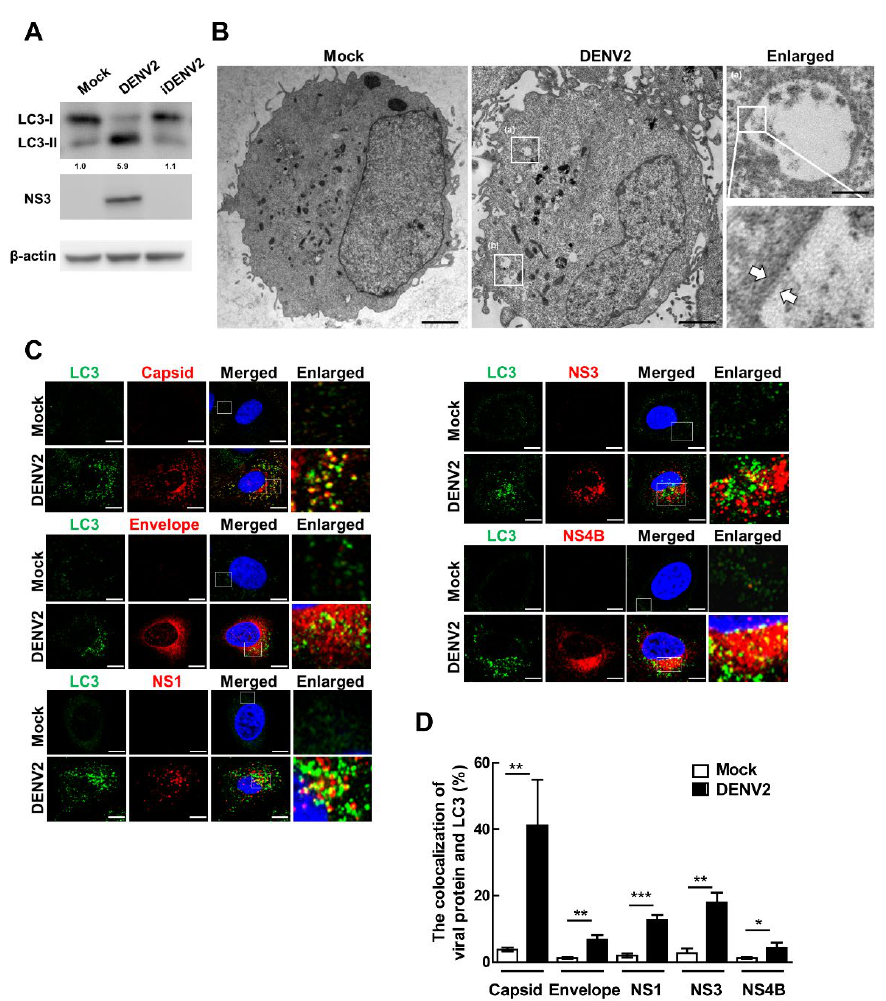
Figure 1. DENV2 increases LC3-II level, autophagic vesicles and viral proteins are colocalized with LC3 protein in infected lung cancer cells. ( A ) A549 cells were treated with mock, live DENV2 (MOI = 10), or heat-inactivated DENV2 (iDENV2; MOI = 10) for 36 h. Protein was extracted from the whole cell lysate and analyzed by immunoblotting for NS3 and LC3 expression. β -actin was used as the internal control. ( B ) A549 cells after infection were fixed at 36 h post-infection (p.i.) and observed under TEM. Scale = 2 µ m. The white arrow represents double-membrane autophagosome in (a). Single membrane autophagic vesicles in (b). Scale bar = 0.2 µ m in the enlarged picture (a). ( C ) Cells were infected with or without DENV2 (MOI = 10) for 36 h and examined for the colocalization of LC3 (green) and DENV2-Capsid, Envelope, NS1, NS3 and NS4B (red) under confocal microscopy. The yellow dots indicate colocalization of DENV2 proteins and LC3. Scale bar = 10 µ m. ( D ) Quantification of the colocalization between DENV2 proteins (capsid, envelope, NS1, NS3 and NS4B) and LC3 puncta in DENV2-infected cells. The percentage of colocalization was quantified by counting the number of yellow dots in the cells and the cells containing more than five yellow dots represent colocalization-positive. Three fields of 10 cells each were countered under each experimental condition. The data shows Mean ± SD and the p values were determined by Student’s t -test analysis. * p < 0.05, ** p < 0.01, *** p <